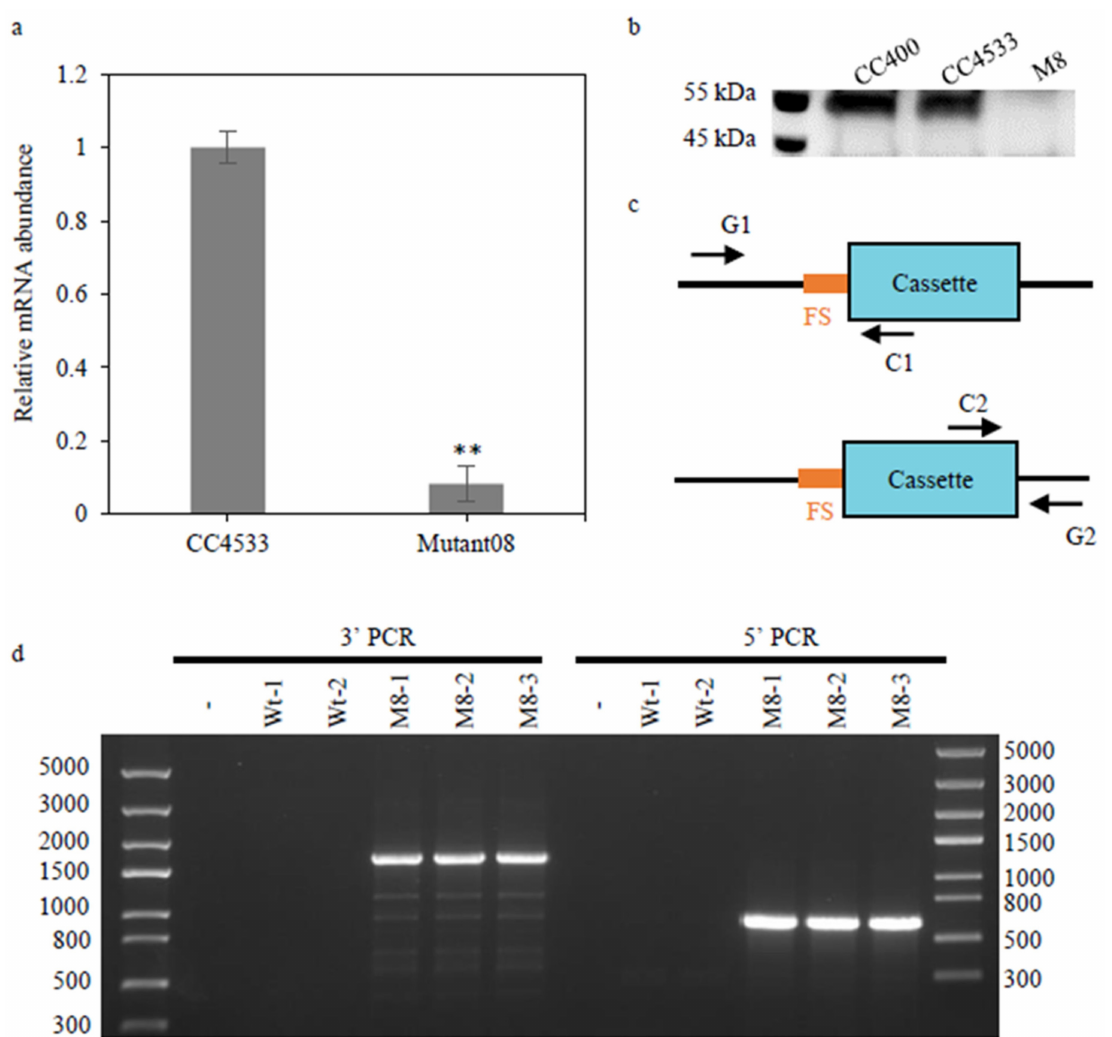
Figure 3. Verification of the insertion in CrGH . ( a ). Relative level of the CrGH mRNA transcript by real-time fluorescent quantitative PCR. The abundance of mRNA was normalized to the mRNA transcript level in wild type cc4533 strain, which was set as 1. Data are presented as average ± SD (n = 3) * p < 0.05, ** p < 0.01. ( b ). Immunoblotting analysis of the protein levels of CrGH in the wild type (cc4533 and cc400) and mutant08 strains. Twenty micrograms of the whole-cell proteins were loaded in each lane. ( c ). Schematic diagram of genome-cassette junction amplification. The flanking DNA sequences (FS) were amplified with PCR primers binding to the cassette and genome. ( d ). Amplification of genome-cassette with the locus disruption. The resulting PCR product was sequenced for identifying the site of each